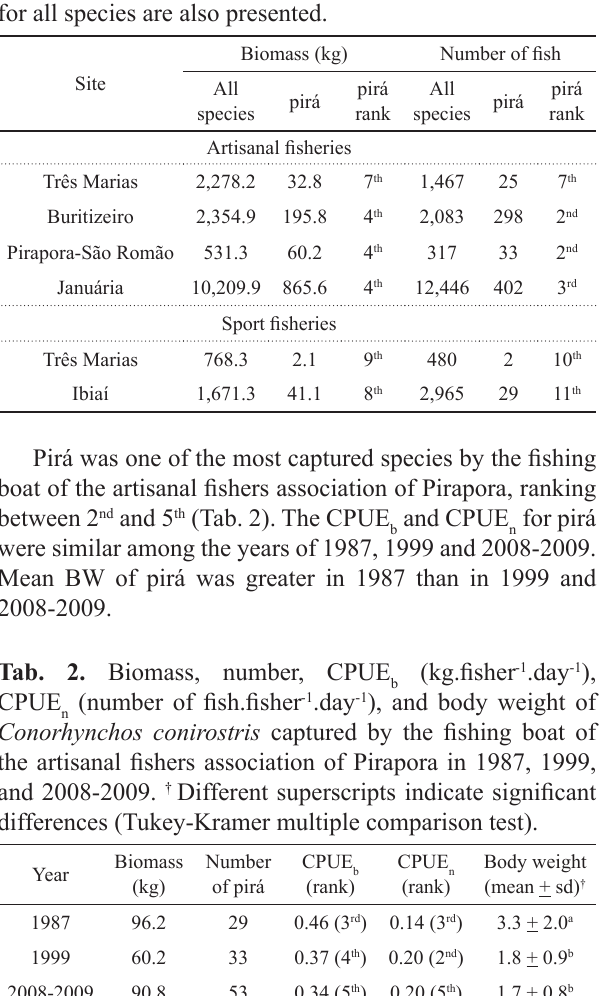
Tab. 1. Biomass and number of Conorhynchos conirostris